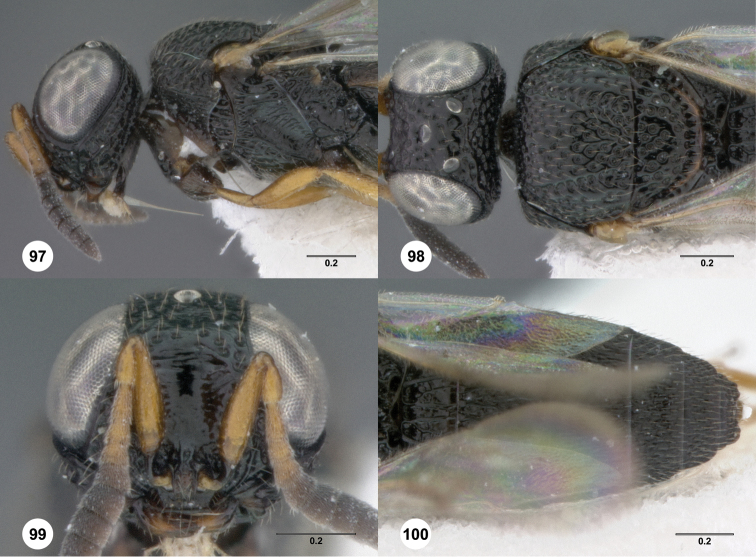
Oxyscelio exiguitatis sp. n., holotype female (OSUC 359682) 97 Head and mesosoma, lateral view 98 Head and mesosoma, dorsal view 99 Head, anterior view 100 Metasoma, dorsal view. Morphbank46